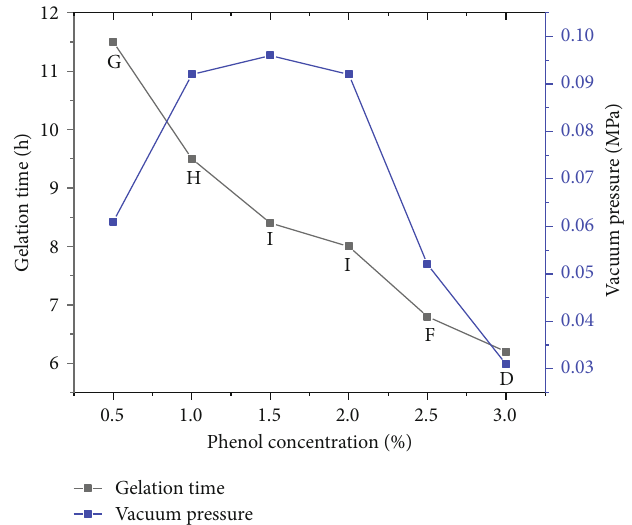
Figure 13: The e ff ect of phenol cross-linking agent concentration on the gel formation and strength of the system.